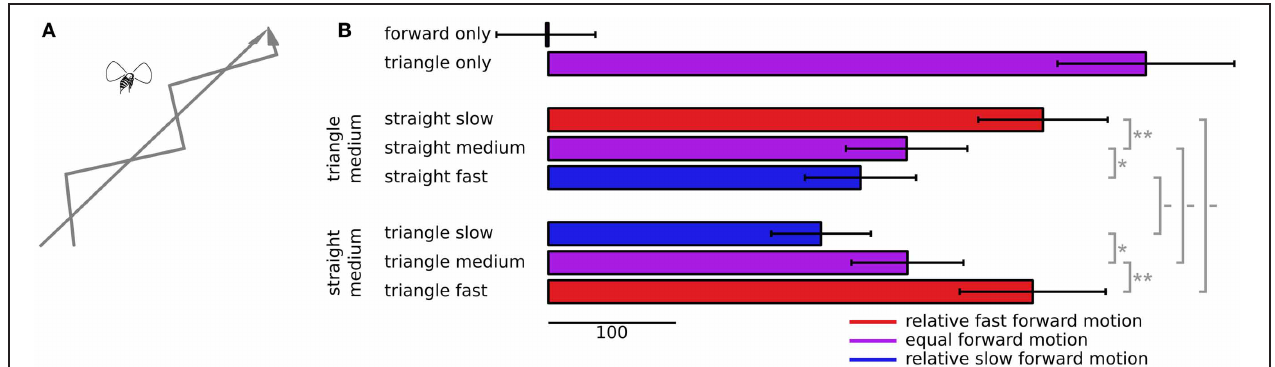
FIGURE 4 | Following behavior to dots slipping back and forth. (A) The dots simulate two conflicting virtual paths for the fly, one straight forward and the other following a triangular waveform trajectory, forward motion plus alternating sideslip motion. (B) Cross correlations between the triangular waveform signal and (cid:2) WBA, with error bars denoting standard error. The top two bars show correlations when the dots moved coherently, either allforward or all slipping back and forth in a triangular waveform pattern. The next three bars down show the correlations when the slipping triangular waveform dots advanced at a constant, intermediate forward speed, and the speed of the